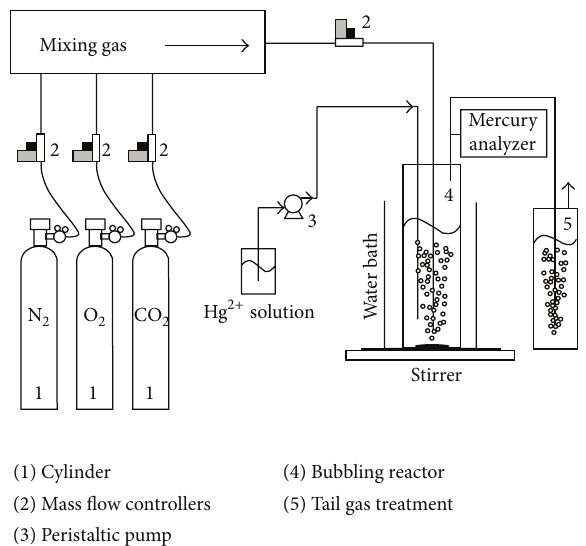
Figure 1: Schematic of the experiment